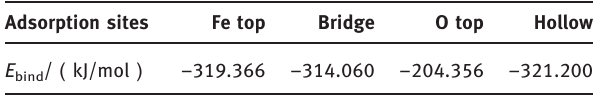
Table 4: Adsorption energy and configuration parameters of adsorption of Cl on FeO(100).